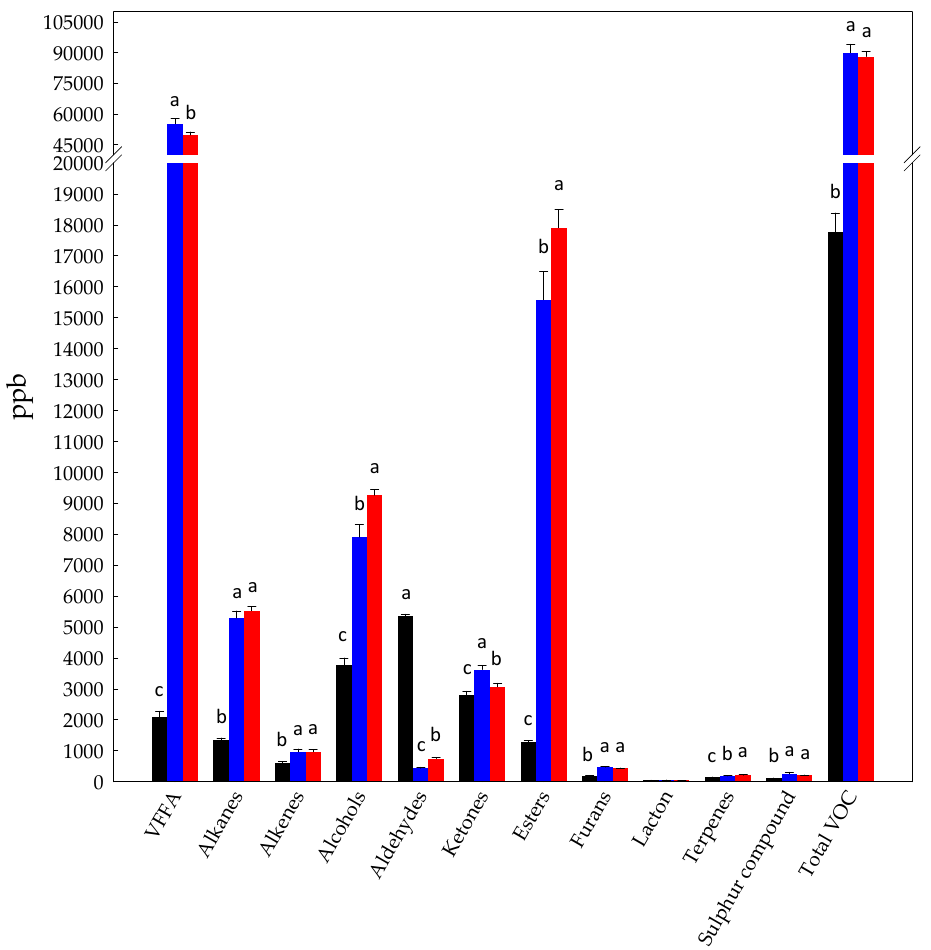
Figure 1. Concentration (ppb) of volatile free fatty acids (VFFA), alkanes, alkenes, alcohols, aldehydes, ketones, esters, furans, lacton (2(3H)-furanone, dihydro-5-methyl-), terpenes, sulphur compound (dimethyl sulfide), and total volatile compounds (total VOC identified in Raw- (black bars), Unstarted- (blue bars), and Started-bee-collected pollen (BCP) (red bars). Data are the means (± SD) of three independent experiments analyzed in triplicate. Data were subjected to one-way analysis of variance (ANOVA); pair-comparison of treatment means was achieved by Tukey’s procedure at p < 0.05. For each chemical group, bars with different superscript letters differ significantly ( p < 0.05).